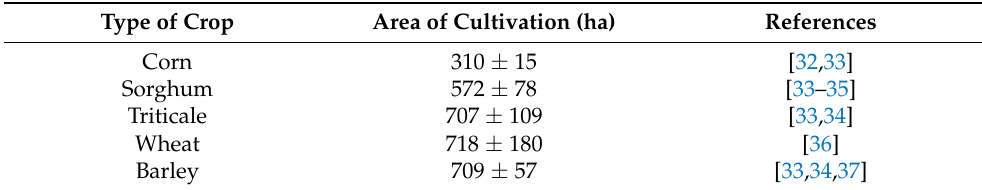
Table 1. Land area necessary to supply, with energy crops, an ABP with an installed power of 1000